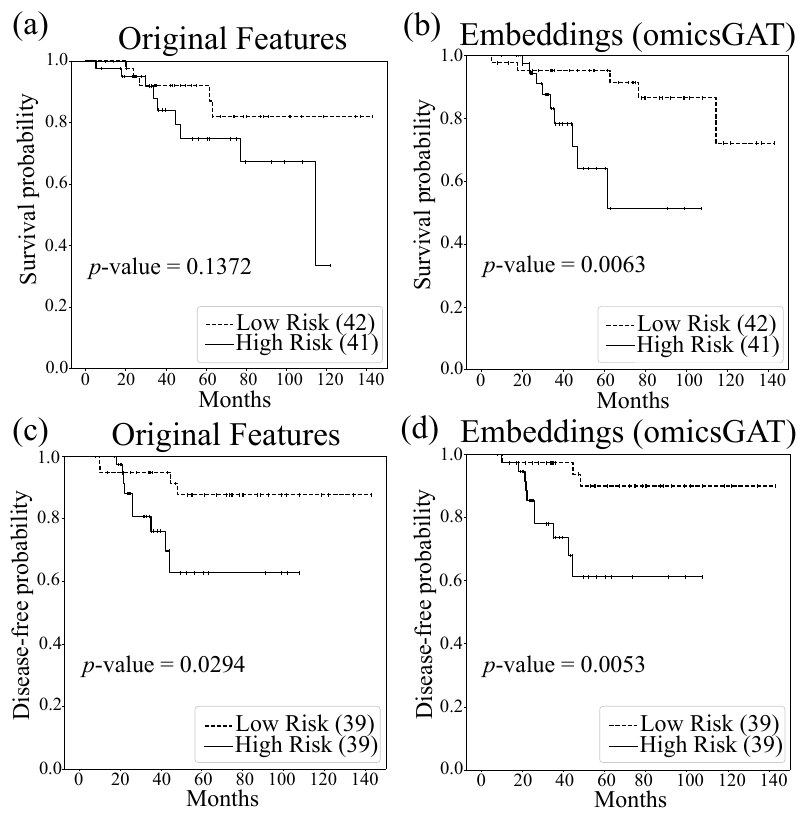
Figure 1. Survival and disease-free time predictions on breast cancer patients with original gene expression and the embeddings generated by omicsGAT. Kaplan–Meier plots for low (dashed line) and high (solid line) risk groups generated by ( a ) original gene expression and ( b ) omicsGAT learned embeddings for survival analysis; ( c ) original gene expression and ( d ) omicsGAT learned embeddings for disease-free analysis. The number in the parenthesis indicates the number of samples in the low- or high-risk group. The p -value is calculated by the log-rank test to compare the overall survival or disease-free probability of two groups of breast cancer